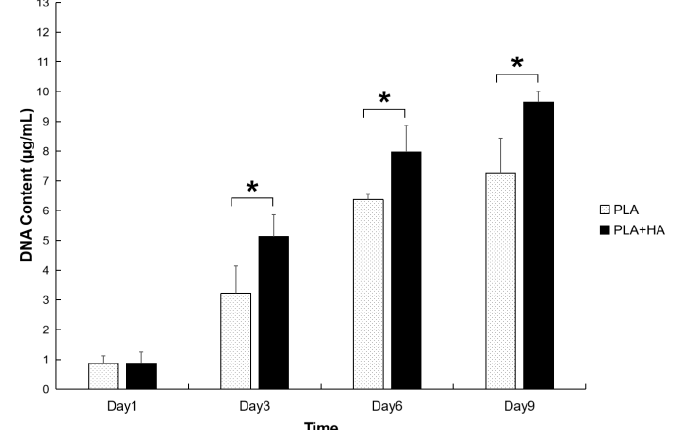
Figure 5. A higher density of cells was observed on the PLA-HA scaffold ( B ) than on the PLA scaffold ( A ) as shown by epi fluorescent imaging of 4 ′ ,6-diamidino-2-phenylindole (DAPI) staining (images were obtained after five days of culture using a lower magnification objective for a larger field of view).